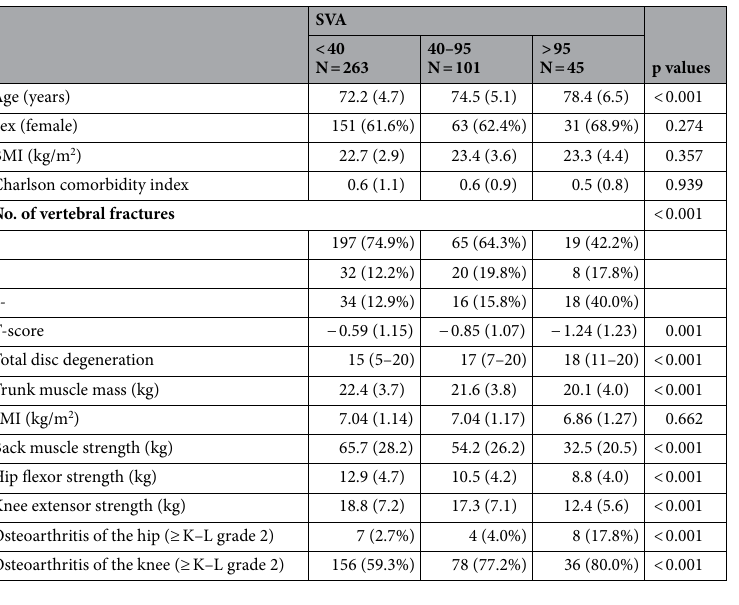
Table 1. Comparison of characteristics according to the sagittal vertical axis. SVA sagittal vertical axis, BMI body mass index, SMI skeletal muscle mass index, K–L Kellgren–Lawrence